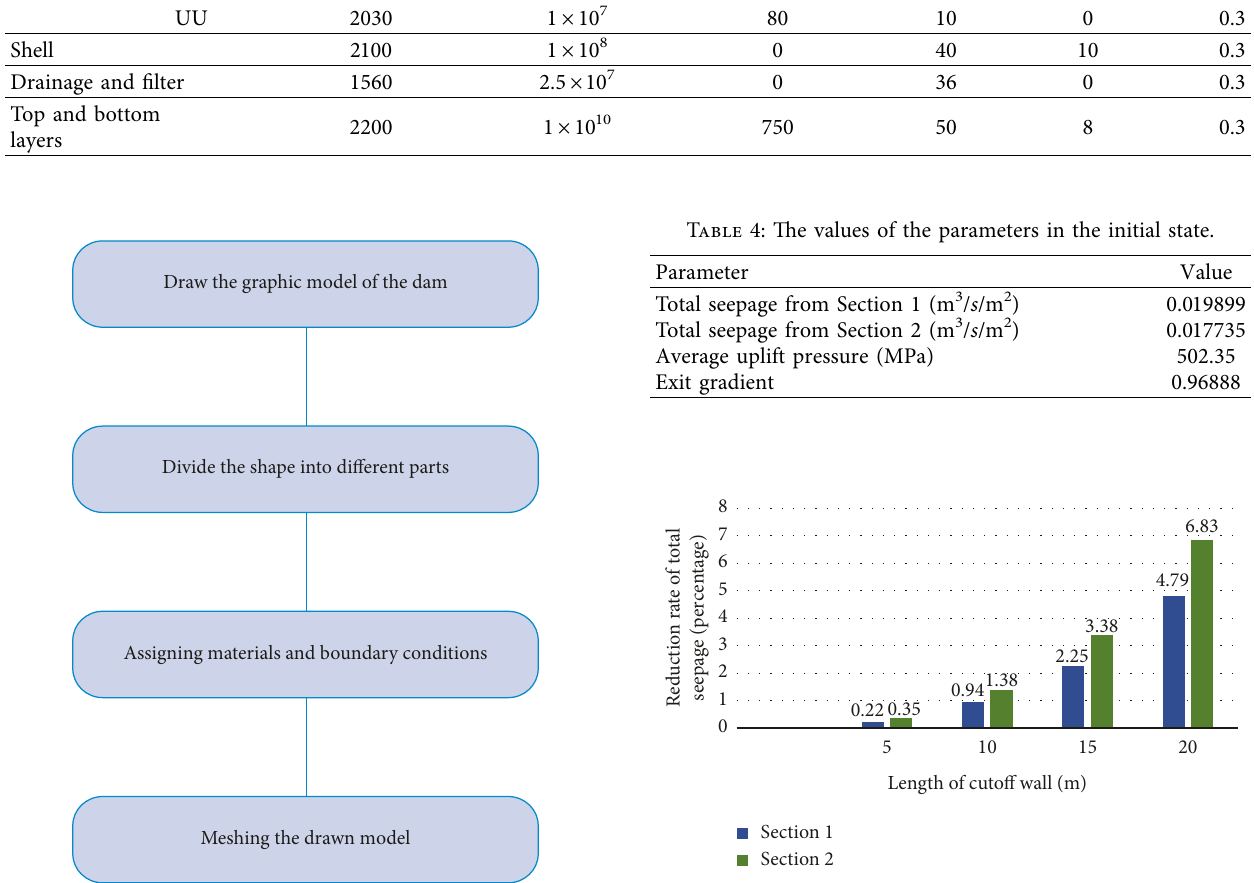
Figure 6: Percentage reduction of total seepage through Sections 1 and